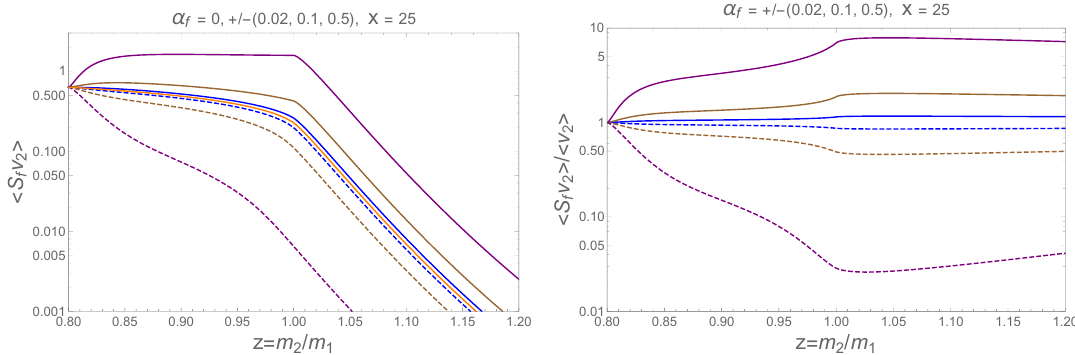
Figure 1 . Left panel: the thermally averaged FSS-corrected s -wave cross section (up to the factor a 0 ), as a function of the mass ratio of the final and initial state particles, for a typical freeze-out value x = m 1 /T = 25 . The solid blue, brown and purple lines are for α f = + 0 . 02 , + 0 . 1 and + 0 . 5 , respectively. The dashed blue, brown and purple lines are for α f = − 0 . 02 , − 0 . 1 and − 0 . 5 , respectively. The orange line in the middle is for α f = 0 , namely, the h v 2 i curve. Right panel: the ratio of the thermally averaged cross sections with and without the FSS effect. That is, it is the same as the left panel, but with the blue, brown and purple lines normalized to the orange